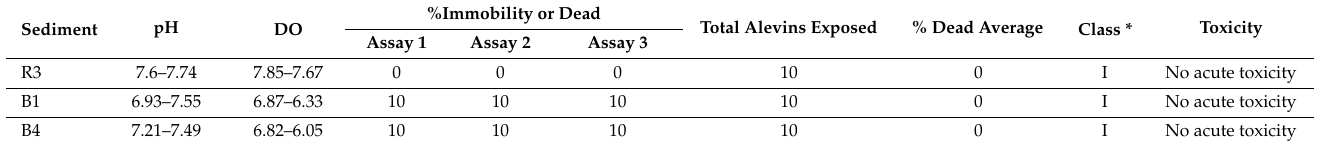
Table 8. Ecotoxicity results for the sediments samples using D. magna .